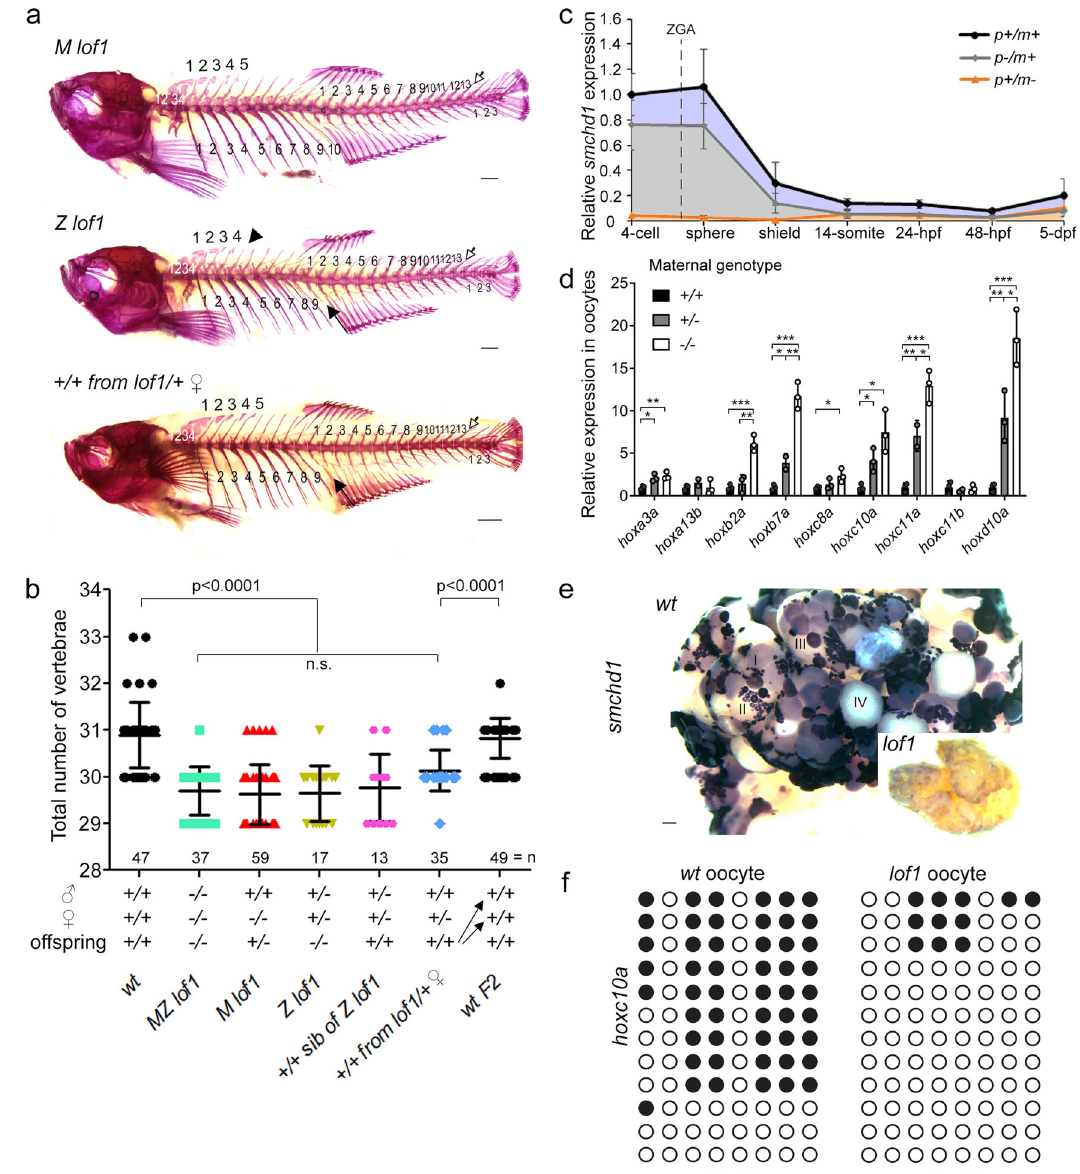
Fig. 3 Skeletal phenotype is caused by maternal Smchd1 haploinsuf fi ciency. a , b Skeletal preparations of fi sh of different genotypes. Phenotypes include loss of a rib ( fi lled arrow), loss of a supraneural vertebra (arrowhead) and loss of a caudal vertebra (open arrow) Scale bar = 1 mm. P values were calculated by the Kruskal-Wallis test followed by Dunn ’ s Multiple Comparison Test. c qPCR shows that there is little to no zygotic smchd1 expression. p: paternal allele; m: maternal allele. n = 3 biological samples. d qPCR shows that hox derepression is already observed in unfertilized oocytes and that oocytes from ± females show intermediate level of hox mis-expression. n = 3 biological samples, p values were calculated by 2-tailed unpaired Student ’ s t test. * p < 0.05, ** p < 0.01, *** p < 0.001. All data are presented as mean values ± SD. e In situ hybridization of smchd1 shows that smchd1 is expressed in developing oocytes. Roman numerals denote stages of oocyte development. Scale bar = 200 µ m. f Bisul fi te sequencing in oocytes shows hypomethylation of hoxc10a locus when smchd1 is knocked germline, where smchd1 depletion in transcriptionally-active unfertilized oocytes of different smchd1 genotypes were isolated. immature oocytes is suf fi cient to cause hox de-repression. In The levels of various hox genes were inversely correlated to the mammals, Smchd1 plays a role in maintaining DNA methylation number of wildtype smchd1 alleles available during oogenesis: the on the inactive X chromosome and other imprinted genes 4,5,17 . highest precocious hox expression was seen in smchd1 lof1 oocytes produced by homozygous smchd1 lof1/lof1 mothers while oocytes produced by heterozygous smchd1 + /lof1 mothers showed inter- mediate levels relative to wildtype oocytes (Fig. 3d). These results lend support to the observed maternal smchd1 haploinsuf fi ciency and correlate with the abundant smchd1 expression in developing oocytes from the earliest stages of oogenesis (Fig. 3e). Our results dramatically from oocyte to ZGA 18,19 (Supp. Fig. 5c). In line with point to a very early defect during gametogenesis in the maternal this, we could document the hoxc10a locus was markedly de-